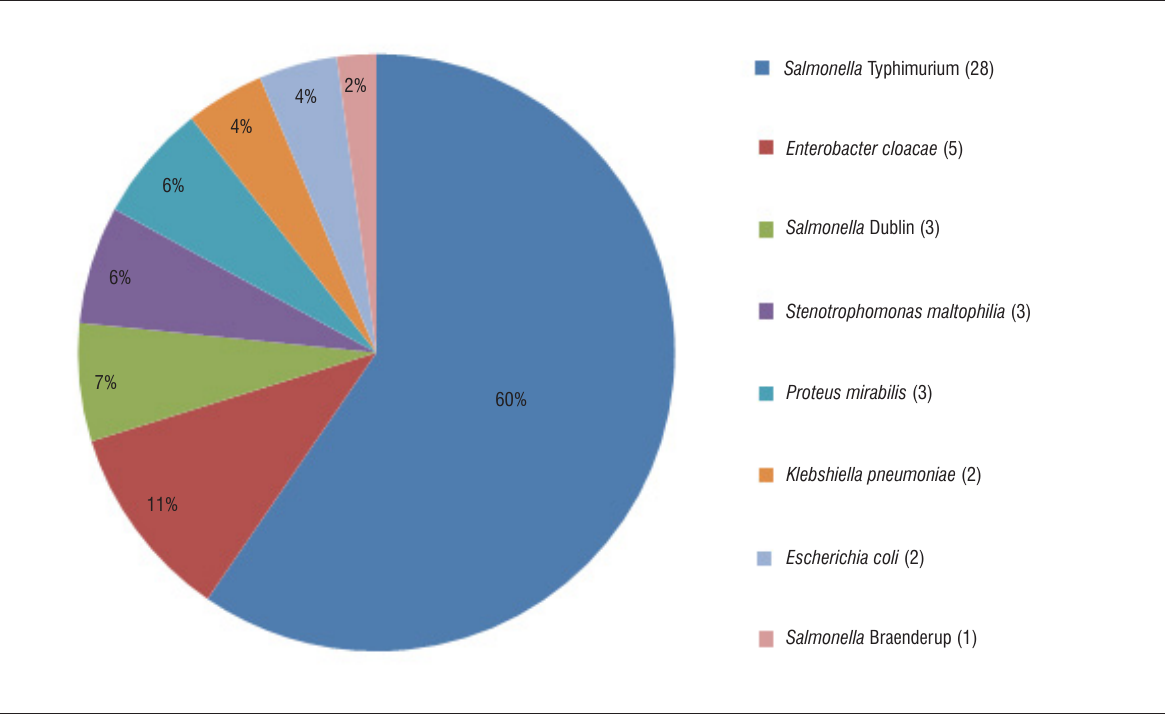
Figure 2: Distribution of presumptive bacterial species identified and confirmed by a Matrix-assisted Laser Desorption Ionisation Time of Flight (MALDI-TOF)